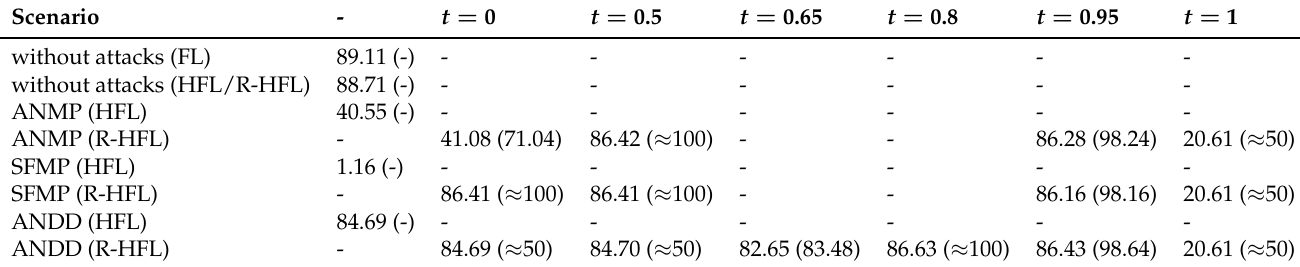
Table 1. Testing and detection accuracy varying with PCS threshold t in different